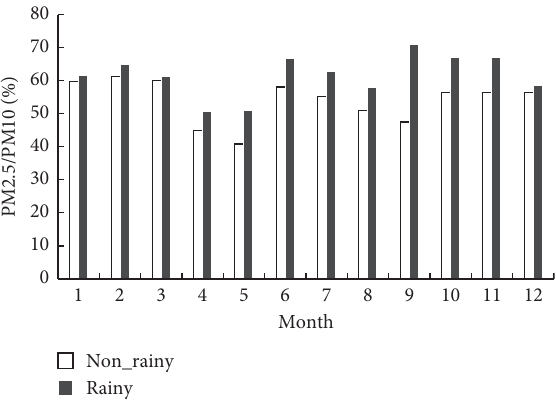
Figure 5: Mass concentration of PM2.5 /PM10 on rainy days and nonrainy days at